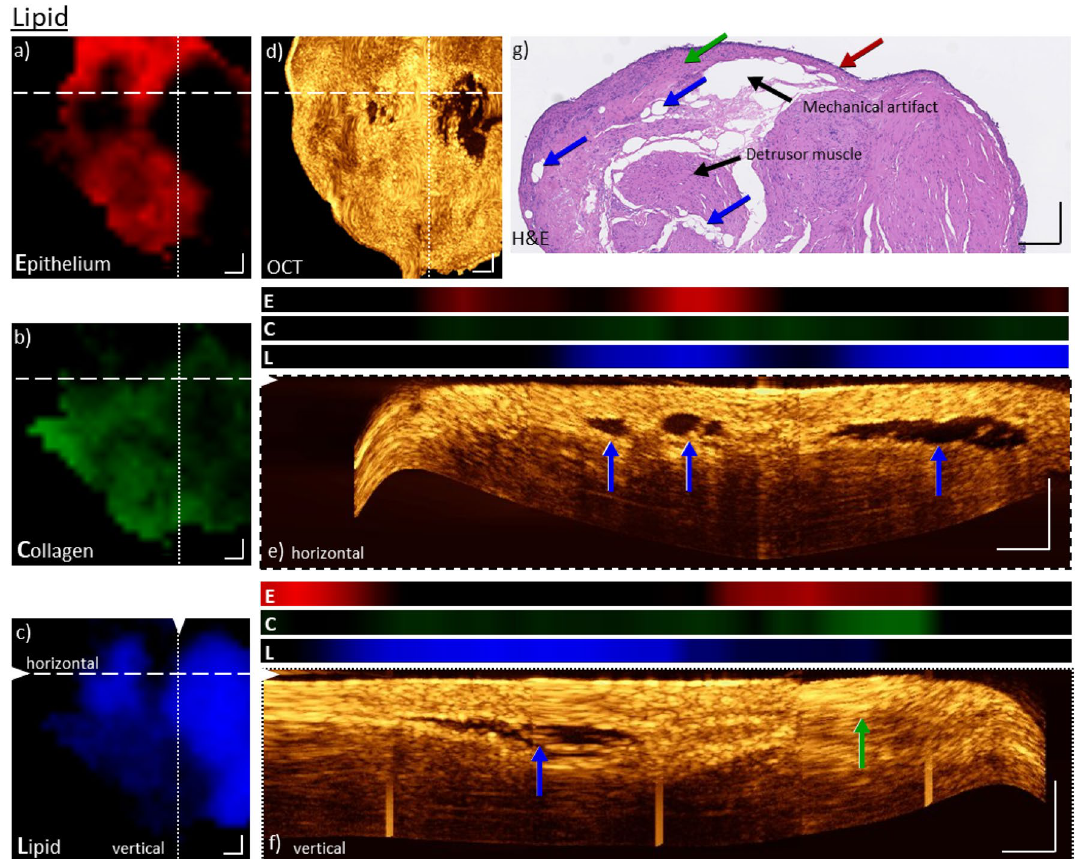
Figure 5. Co-registered, morpho-molecular information of OCT and Raman images on a bladder biopsy with high lipid contributions. Enface Raman maps for epithelium ( a ), collagen ( b ) and lipid ( c ), show the presence and distribution of all three components, and specifically very pronounced lipid pools. The enface OCT maximum intensity projection of ten slices from a depth of 150–180 µm ( d ) indicates black voids, correlating to the same locations as the lipid signals observed in the Raman map ( c ). Maximum intensity projections of ten cross-sectional OCT B-scans, positions indicated by dashed and dotted lines in the enface image ( e , f ) with co-registered molecular Raman information (E: Epithelium, C: Collagen, L: Lipid). In both images, the overlap of lipid Raman signals and the black voids in the OCT cross-sections in a depth of ~ 200 µm is visible. The straight vertical line arising from the bottom to the top in ( f ) is caused by artifacts of the used OCT probe. For comparison, the H&E image of the biopsy, where the blue arrows indicate the identified lipid pools, is shown in ( g ). Here, epithelium (red arrow), lamina propria (green arrow), detrusor muscle and mechanical artifact are also visible. Further, the collagen signal is correlated to a brighter area in the OCT cross-section (f, green arrow). Scale bars: 250